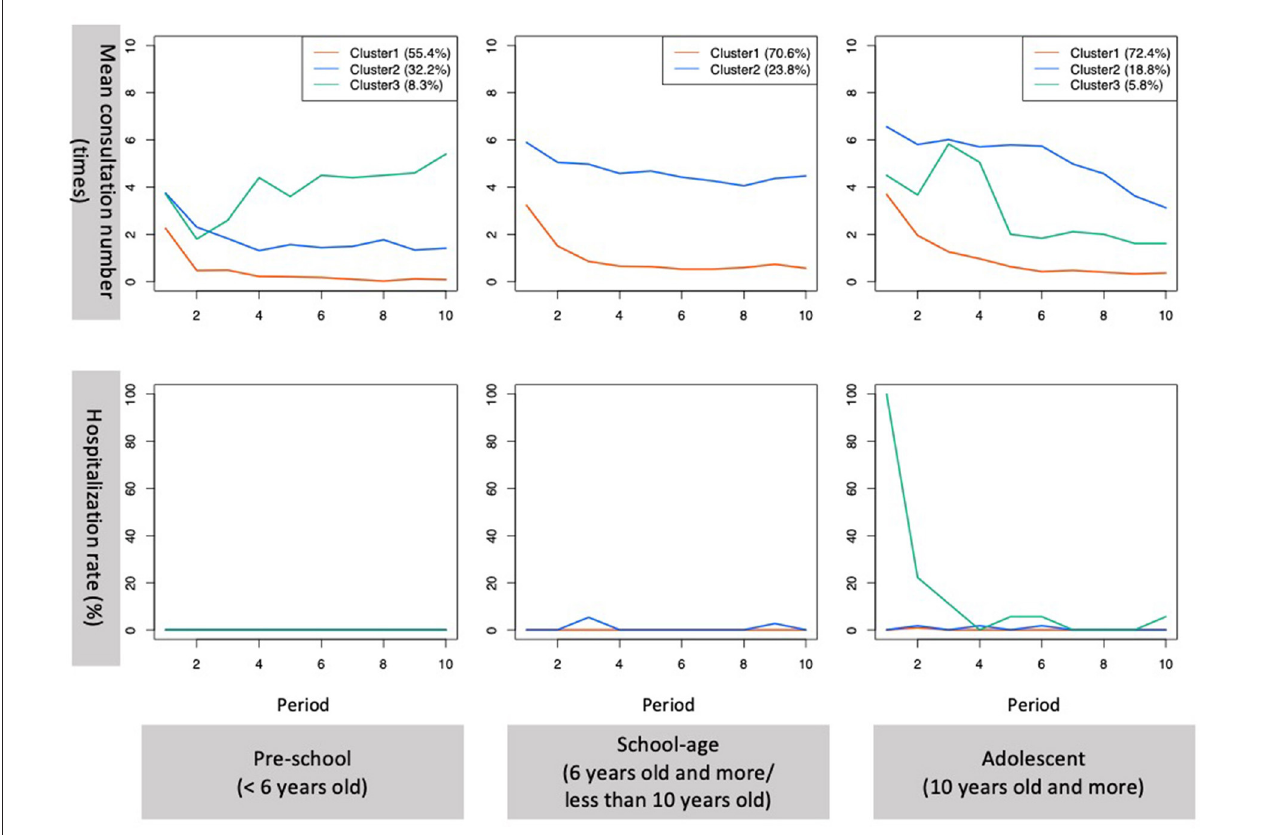
FIGURE 1 | Mean consultation number and hospitalization rate per period for the major clusters. Period 1–10 indicate 10 consecutive half-year periods. Period 1 is April 2015 to September 2015 and period 10 is October 2019–March 2020. Only the trajectories of the major clusters in each age group are presented. Red, blue, and green lines indicate clusters 1, 2, and 3 for each group,